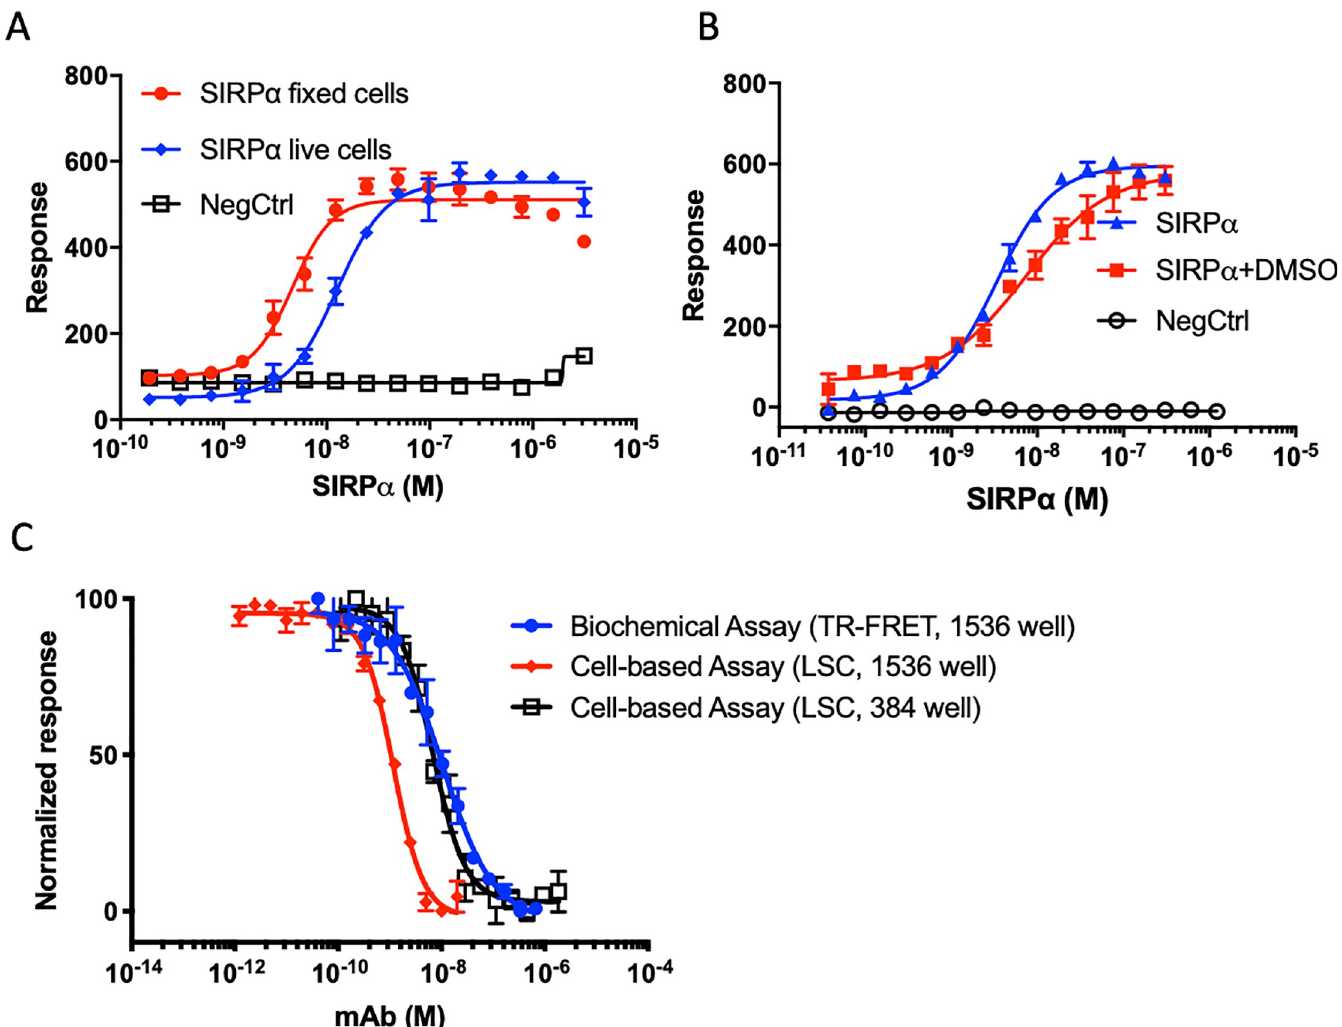
Fig 5. Adaptation of the LSC assay to measure CD47-SIRP α on fixed vs. live cells. (A) Comparison of SIRP α binding to CD47(+) Jurkat cells before and after fixation or (B) with and without DMSO. NegCtrl indicates background nonspecific binding (-SIRP α ). Error bars indicate standard deviation of n = 4 replicates. (C) Comparison of inhibitor (anti-CD47 Mab clone B6H12) activity in the biochemical assay of CD47-SIRP α (TR-FRET) and the cell-based assay (LSC); using a 384 and 1536 well plate format as indicated. The 1536 well LSC assay employed a fixed SIRP α concentration of 10 nM bound to CD47(+) Jurkat cells. Error bars indicate standard deviation of n = 16